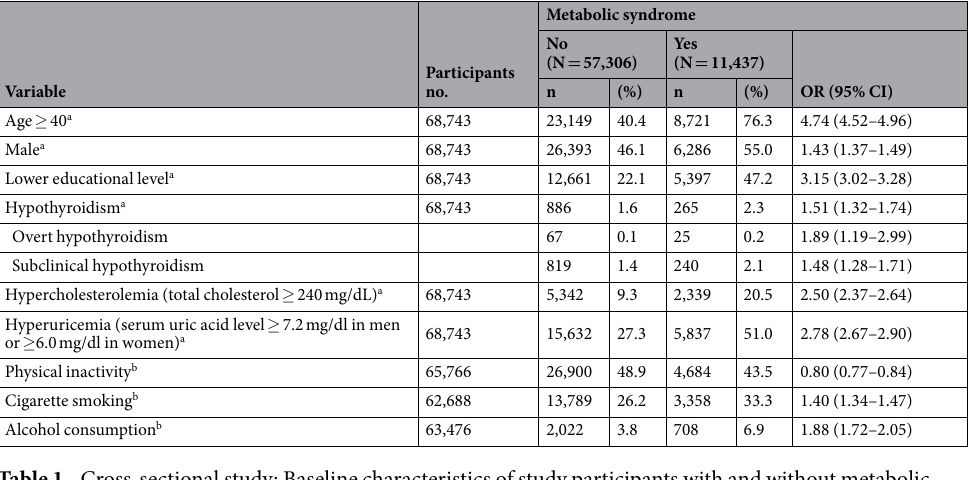
Table 1. Cross-sectional study: Baseline characteristics of study participants with and without metabolic syndrome (N = 68,743 a,b ). a Items could be evaluted in all the 68,743 subjects. b Due to missing data in some variables, the participant numbers that could be evaluated were 65,766 for physical inactivity, 62,688 for cigarette smoking, and 63,476 for alcohol